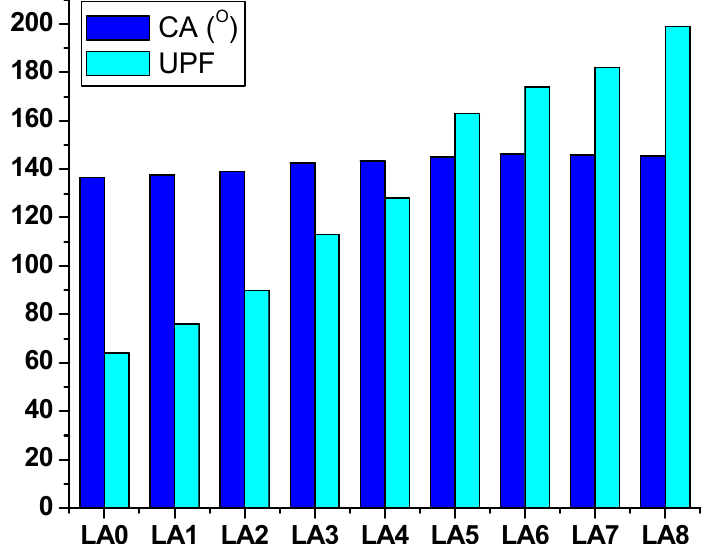
Figure 8. Contacting angle (CA) and ultraviolet protection factor (UPF) of GLS@PET.